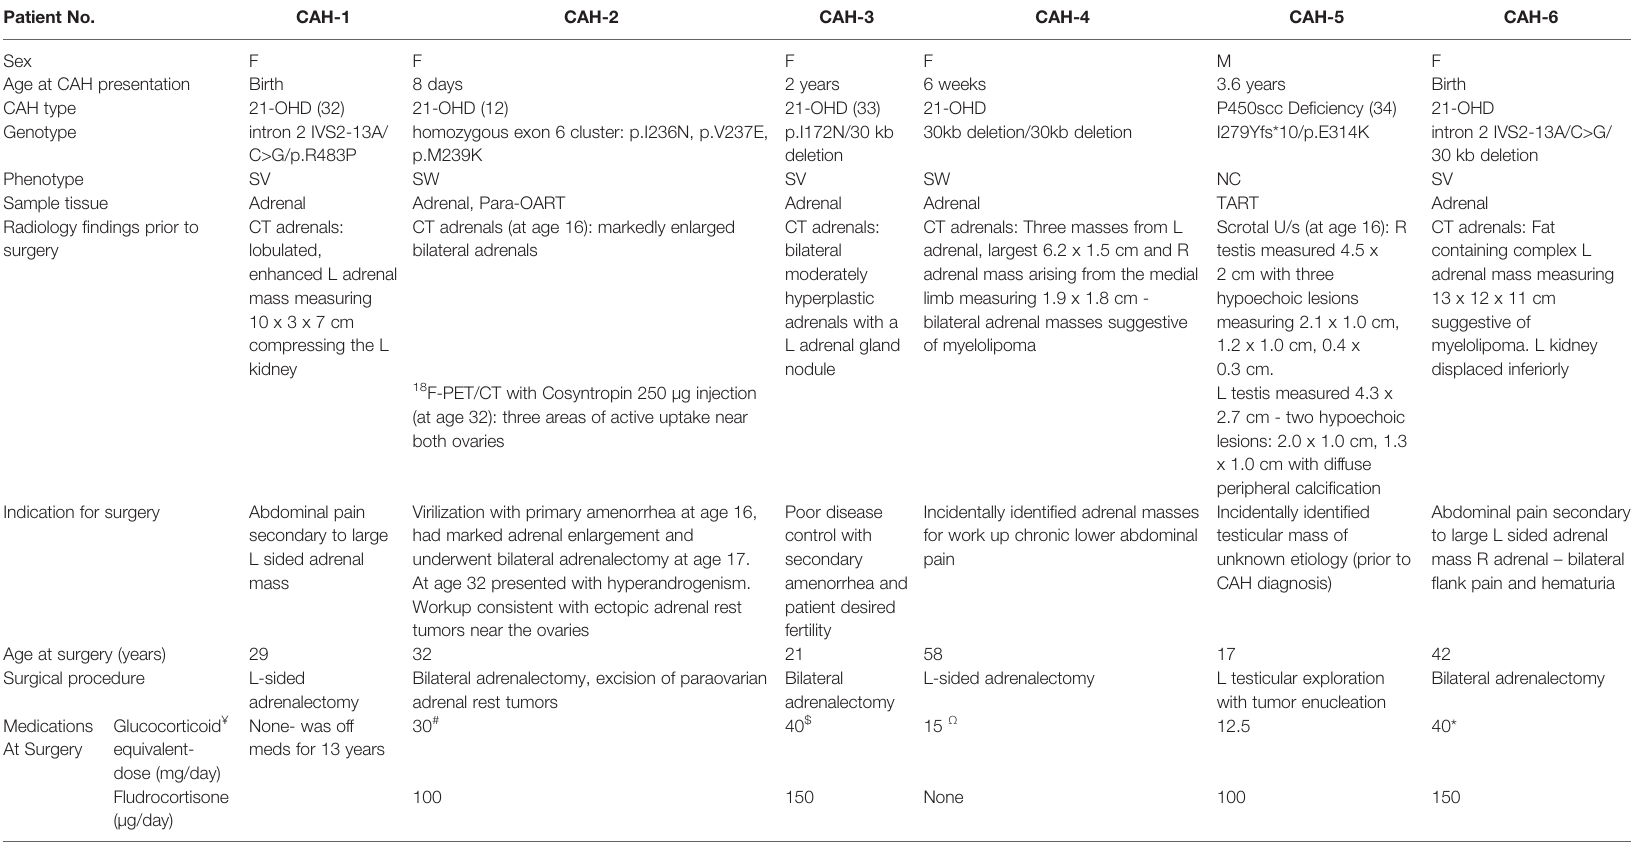
TABLE 1 | Clinical, genetic and radiological fi ndings of six patients with adrenal and/or adrenal rest masses. Patient